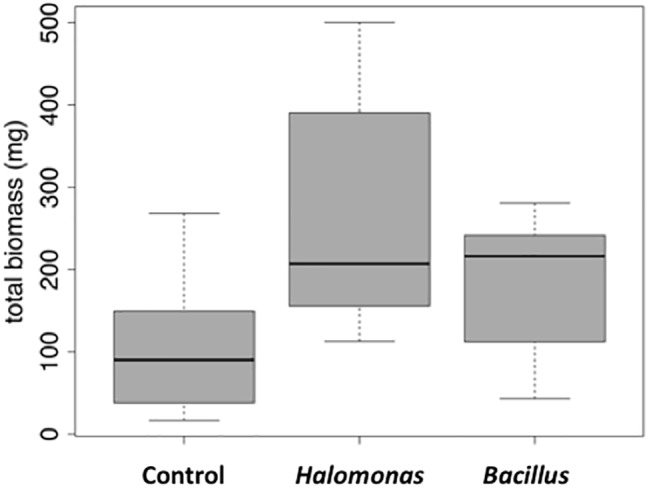
Box and whisker plot of stimulation of alfalfa growth by bacterial inoculation in the presence of 1% NaCl. Total mass is in milligrams. LB, control (no bacterial inoculation). Grown in the laboratory in replicate pots with three plants per pot.